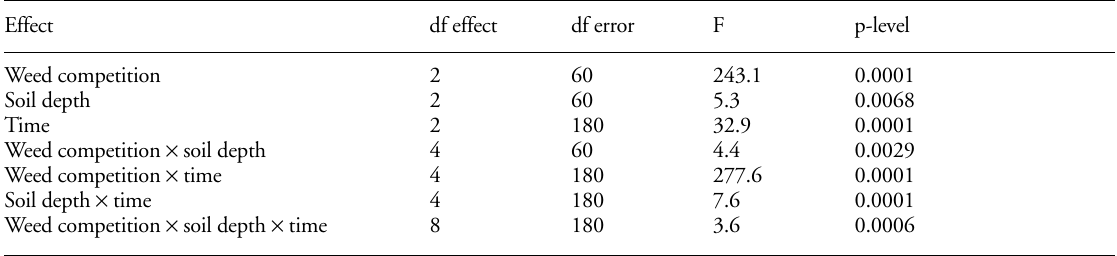
Table 1. Results of a repeated-measure ANOVA used to test the effects of weed competition, soil depth, and time on soil moisture before the application of the irrigation treatment.